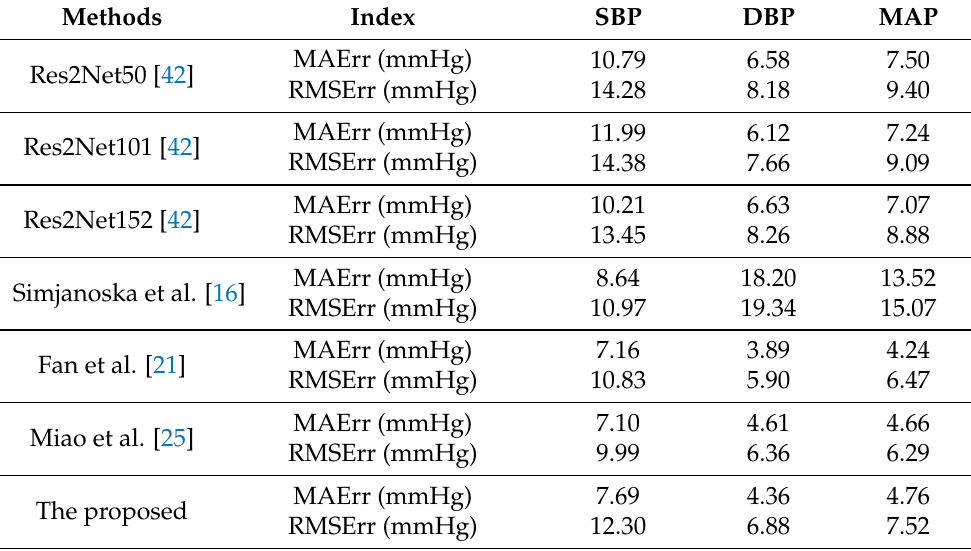
Table 5. BP Estimation Performance Comparison with Deep Learning methods.